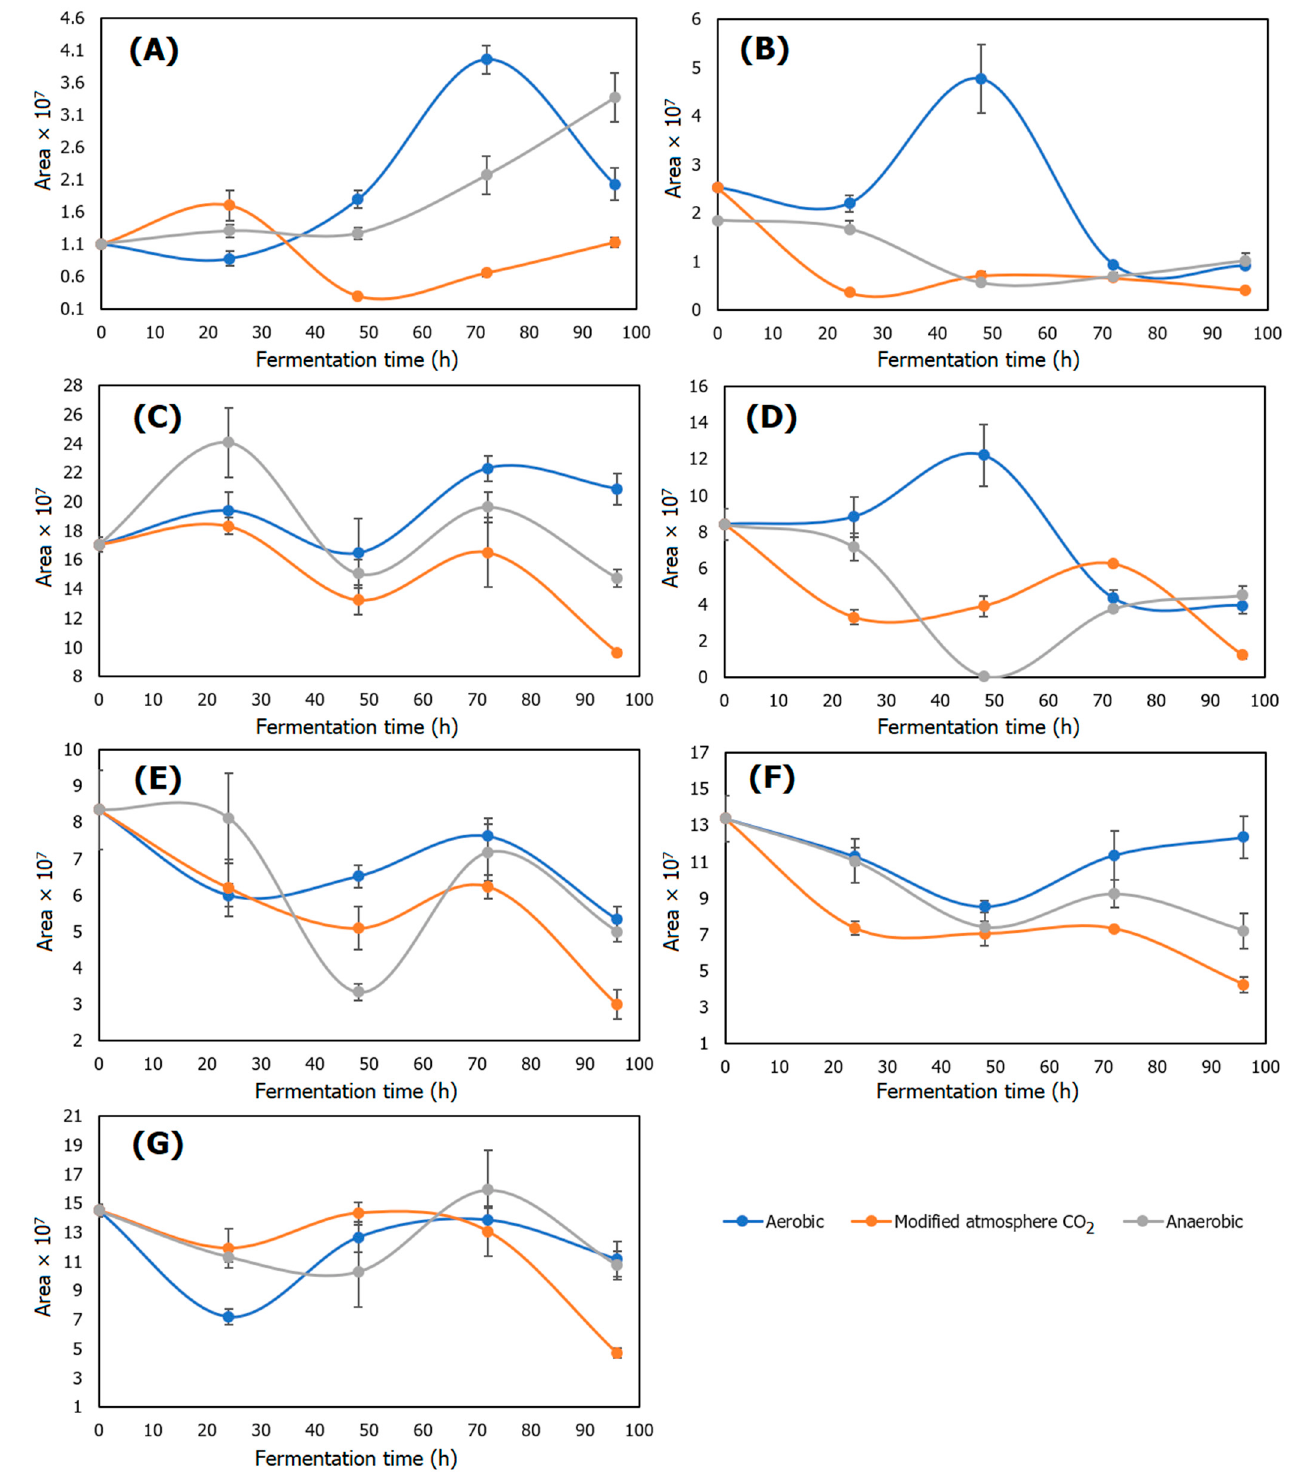
Figure 4. Effect of fermentation time on the concentration of volatile compounds. ( A ) Acetic acid content, ( B ) 2-methylpyrazine content, ( C ) 2-furancarboxaldehyde content, ( D ) 2-furanmethanol content, ( E ) 2,6-dimethylpyrazine content, ( F ) 5-methylfurfural content, and ( G ) 2-methoxy-4-vinylphenol.